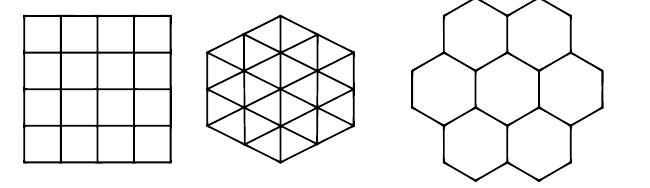
Figure 1. Regular plane